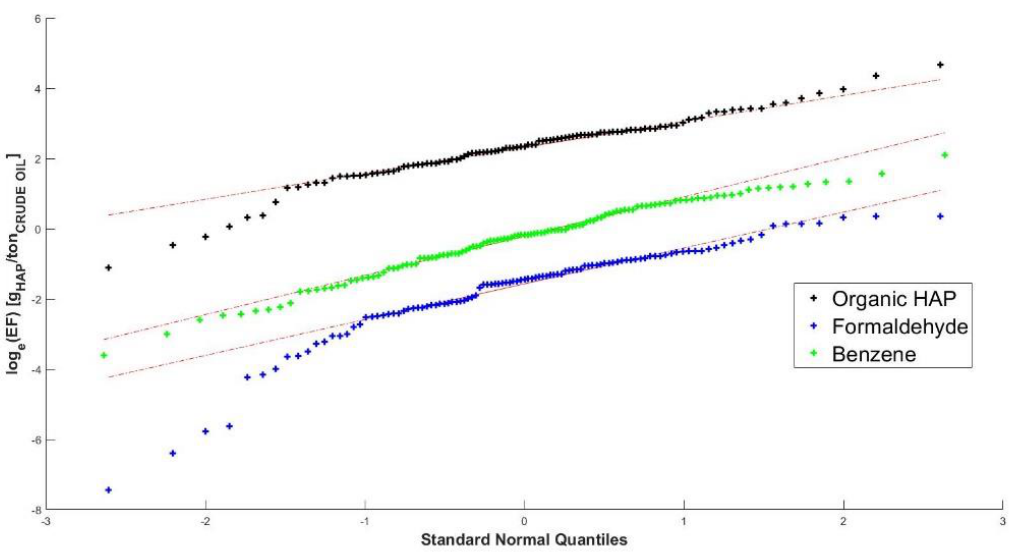
Figure 6. QQ-Plot for the three datasets.